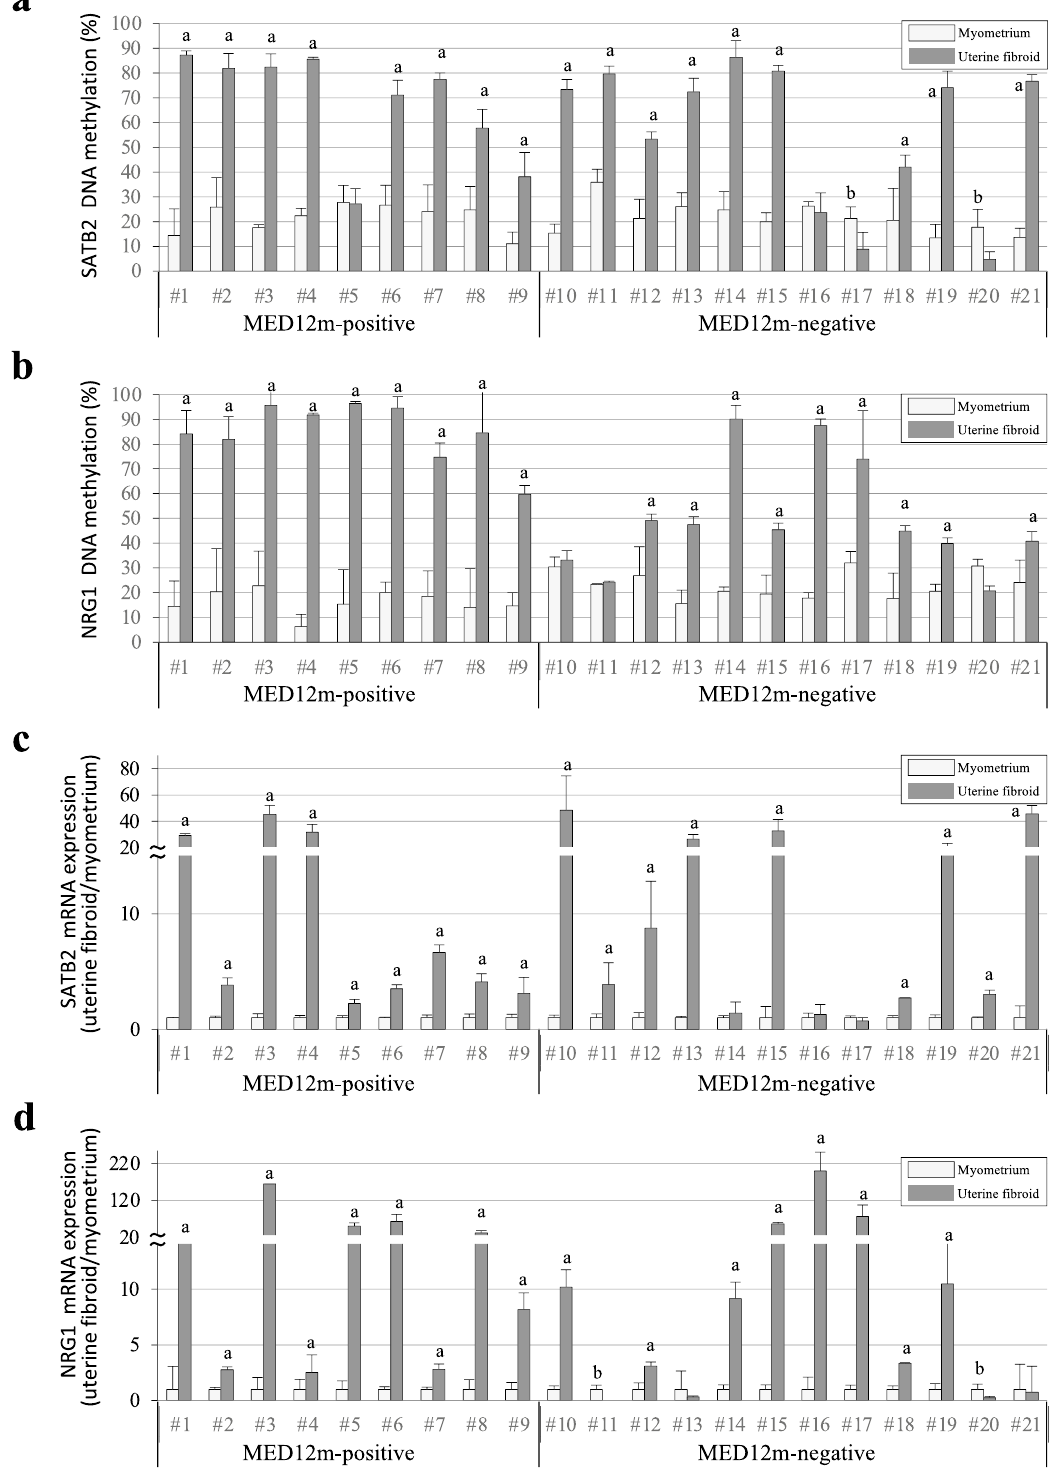
Figure 6. DNA methylation and mRNA expression statuses of SATB2 and NRG1 genes. ( a , b ) The DNA methylation levels of SATB2 ( a ) and NRG1 ( b ) genes are shown in dot plots. The vertical axis indicates the DNA methylation levels in the MED12m-positive uterine fibroids (n = 9), -negative uterine fibroids (n = 12), and the corresponding myometrium. The DNA methylation levels were examined by COBRA and range from 0 to 100%. ( c , d ) The expression levels of SATB2 ( c ) and NRG1 ( d ) genes in the MED12m-positive uterine fibroids, -negative uterine fibroids, and the myometrium analyzed by qRT-PCR are shown in dot plots. The expression levels are corrected for myometrium expression as 1. a p < 0.01 (higher expression in uterine fibroids compared to myometrium, student t-test). b p < 0.01 (lower expression in uterine fibroids compared to myometrium, student